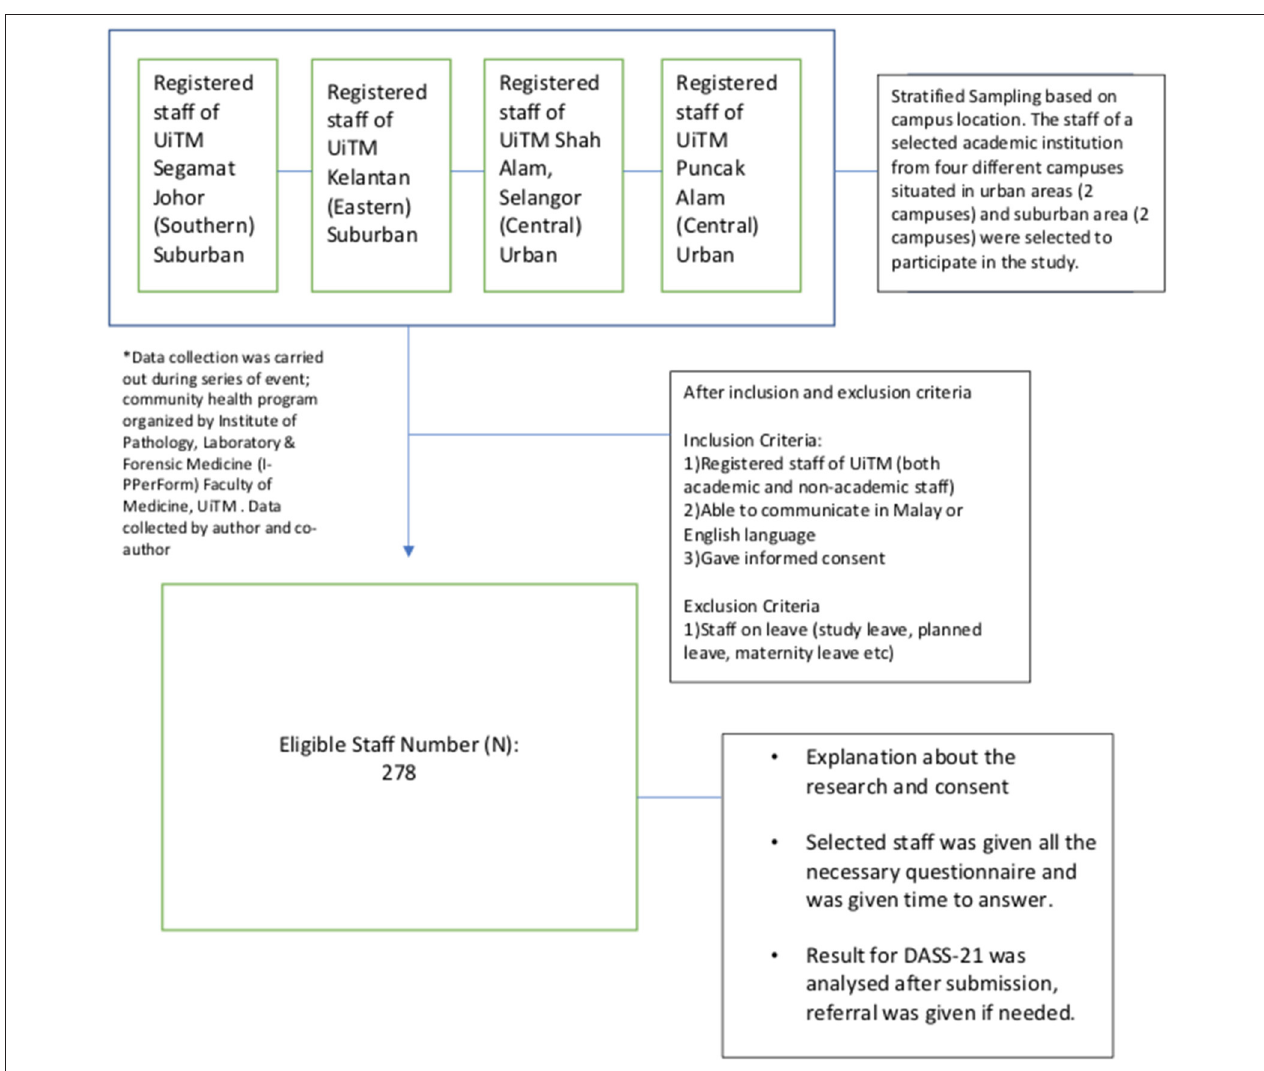
FIGURE 1 | Flow chart of the technique used in selecting